Question: Write a single sentence explaining what this figure depicts.
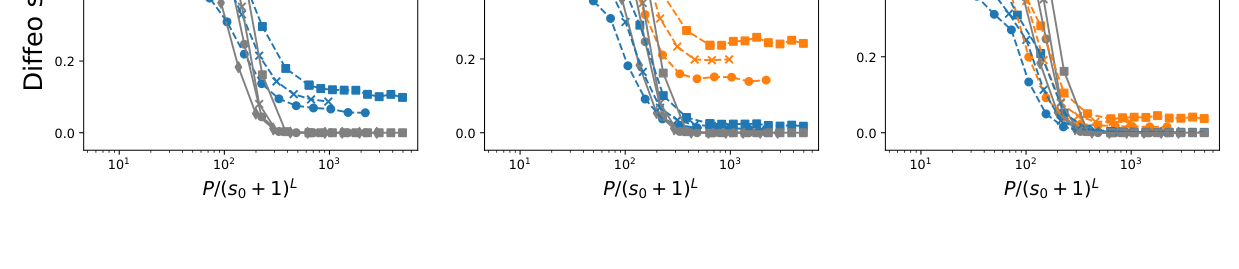
Answer: Top: sensitivity to synonyms exchange Sk,l Eq. 13 of a L−layer LCN, trained on the SRHM with L = 2, s = 2 and m = v = nc = 8, versus number of training points P rescaled by prediction Eq. 3. Going from left to right column the network layer k increases from the layer closest to the input to the output. For each column at fixed k there are plotted in color the sensitivities Sk,l to synonyms exchange at the data level l ∈[1, ..., L], and in grey the test error. Different markers stand for different s0. Bottom: same as top, but with the sensitivity to diffeomorphisms Dk,l Eq. 14. The sensitivities S2 and D2 defined in Eq. 6 and Eq. 7 relate to the case k = 2 and l = 1 here.